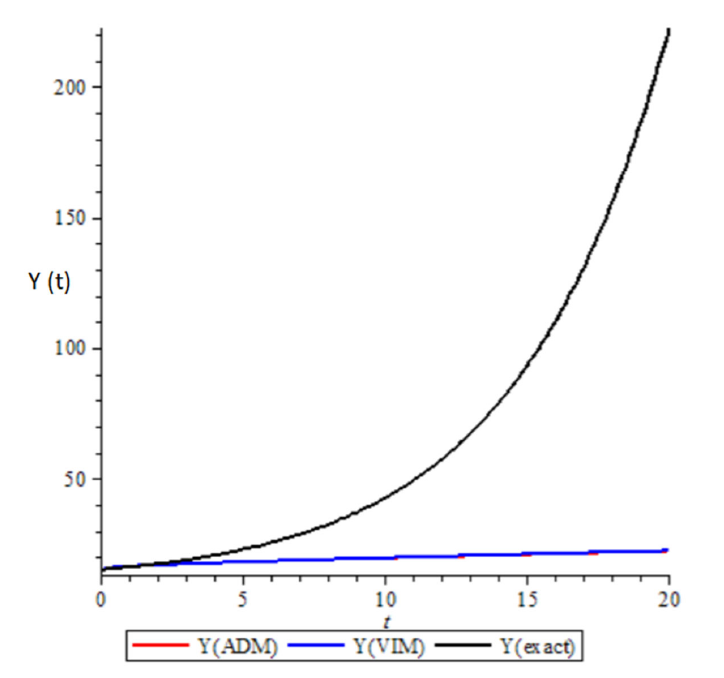
Fig. 2. Graphical output 𝑌 ( 𝑡 ) with 𝛼 = 0.4 for 𝑌 (0) = 15 , 𝑏 = 3 , ( 𝑃 − 𝑎 ) = 0.3 , 𝑚 = 25 , 𝑣 = 40 The numerical simulation using ADM and VIM of output value Y(t) with α =0.9 and 0.4 (0 ≤ t ≤ 10) and its exact